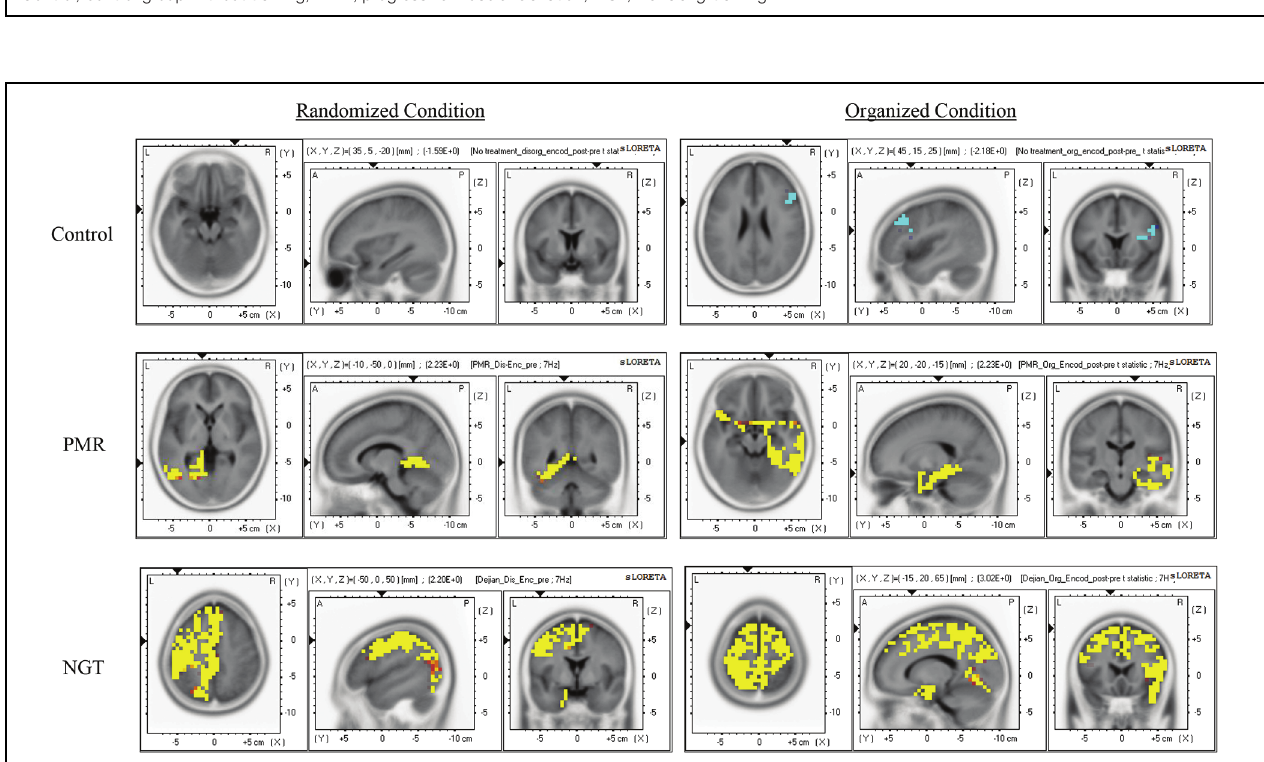
FIGURE 5 | Graphical representation of the sLORETA paired t -statistics results comparing the pre- and post-training theta source activity of the three groups in the randomized and organized conditions. The regions colored in yellow/red indicate significantly elevated activity after training, while those colored in blue indicate significantly reduced activity, p < 0.05. Control, control group without training; PMR, progressive muscle relaxation; NGT, Nei Gong training.